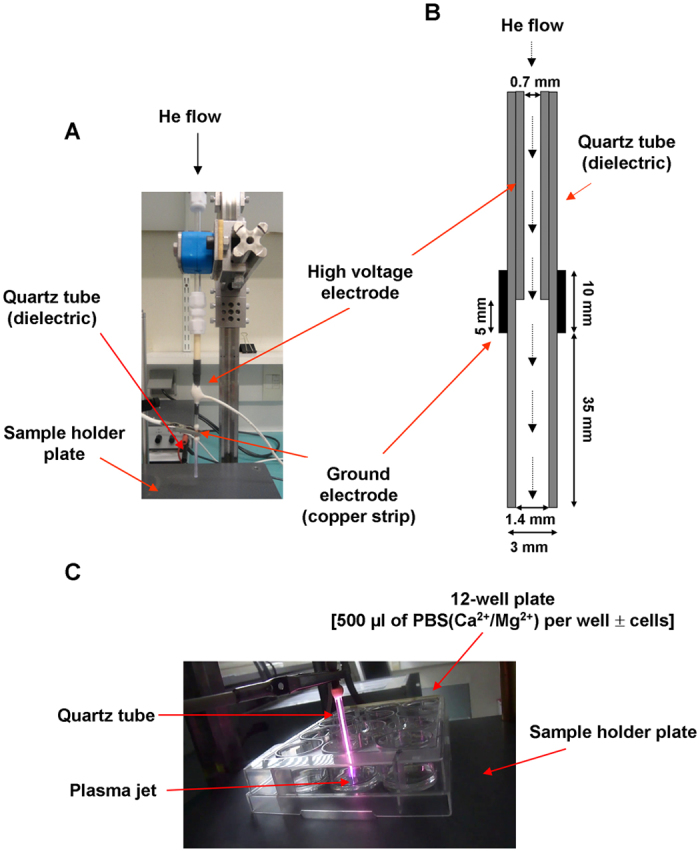
Scheme of the plasma device.(A) Photograph of the home-made plasma jet system. (B) Schematic illustration of the plasma jet used in this study. (C) Photograph showing the interaction between the plasma jet and a solution of PBS(Ca2+/Mg2+) poured in a 12 well plate.